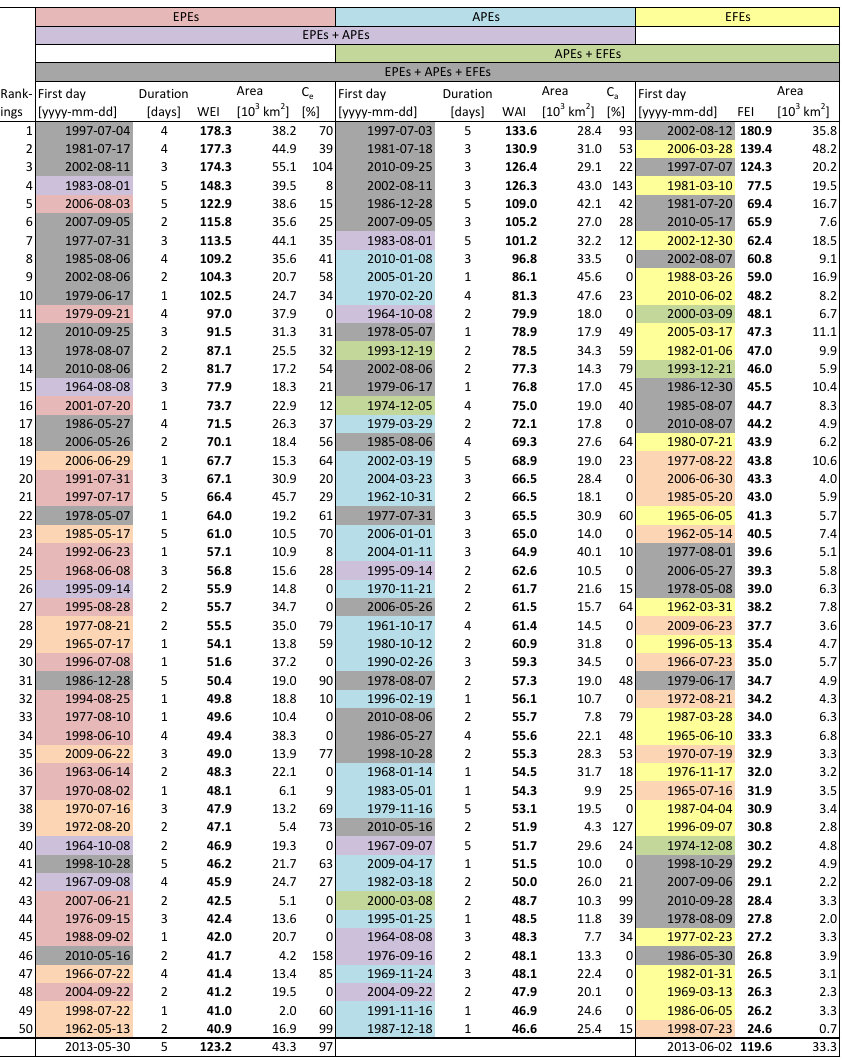
Figure 6. EPEs, APEs, and EFEs in the Czech Republic, 1961–2010. Colors denote the assignment of events to one or more types of extremes; the ratios of the FEI to the WEI and to the WAI are designated the C e and C a , respectively. For comparison, an extra event from May–June 2013 is represented by values of the WEI and the